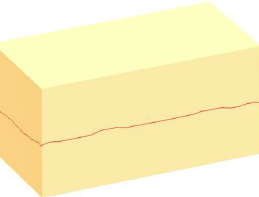
Figure 10. Example of seepage model ( JRC = 3).